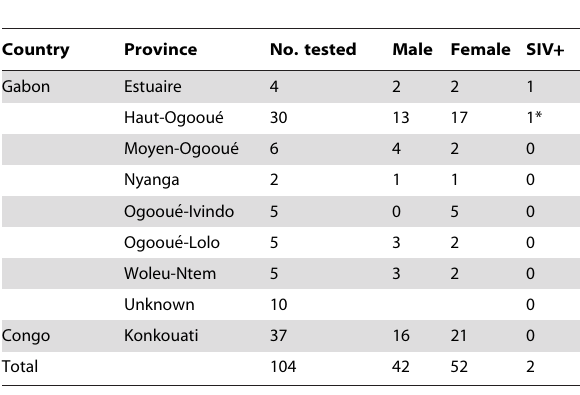
Table 1. Numbers of samples collected from wild-born chimpanzees by geographic origin, sex and SIV